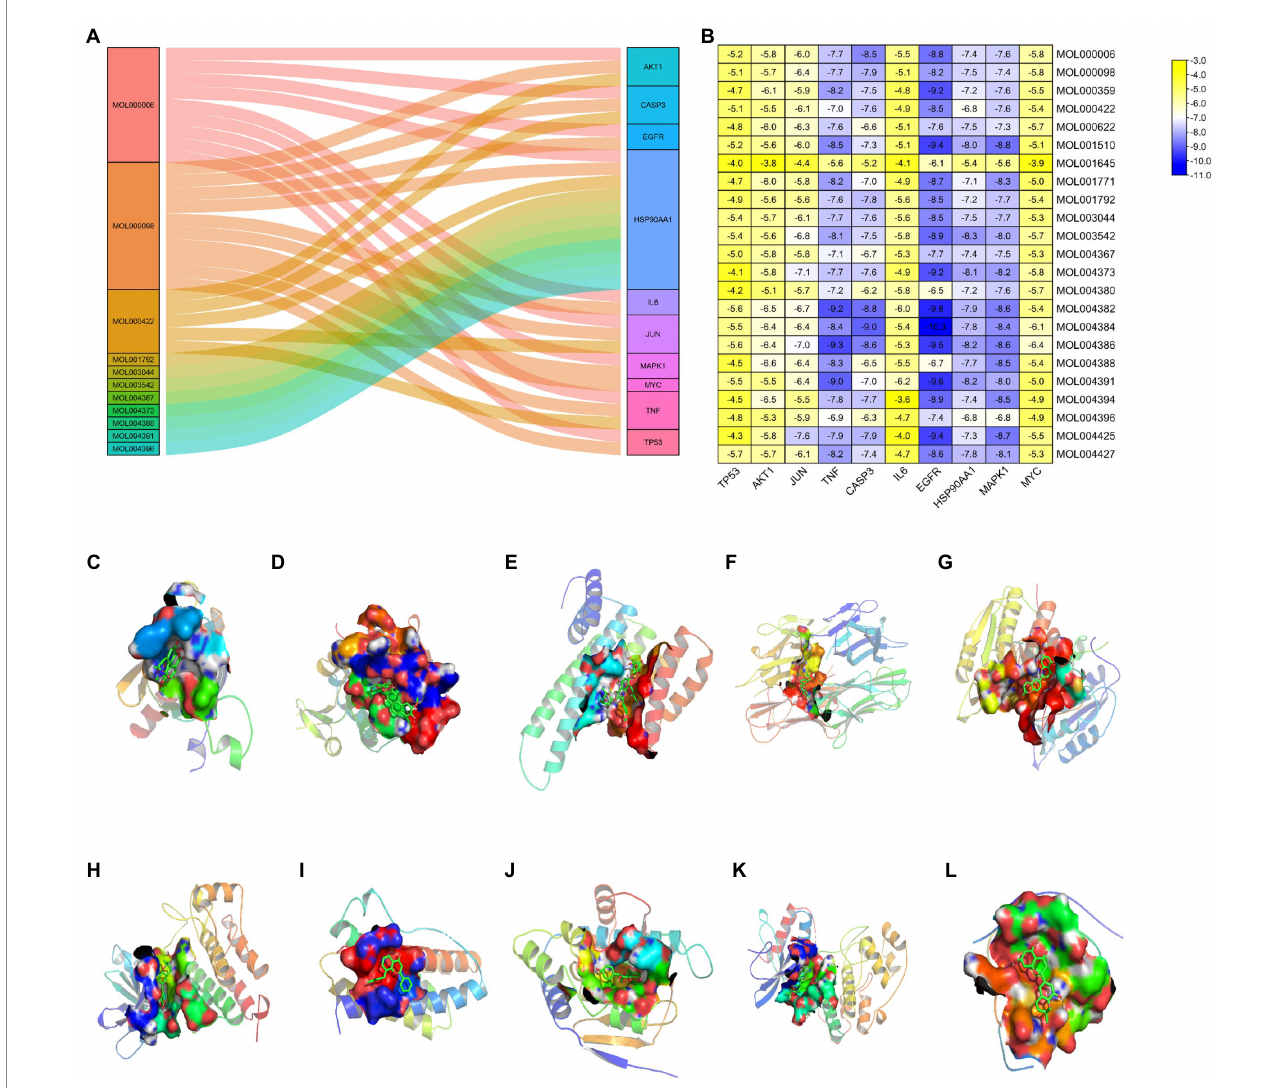
FIGURE 6 Molecular docking between active ingredients and key targets. (A) Sankey diagram of “compounds-targets.” (B) Heatmap of the scores of molecular docking in this study. The darker the color, the better the binding of active ingredient to the key target. (C) MOL004388 to AKT1. (D) MOL004427 to